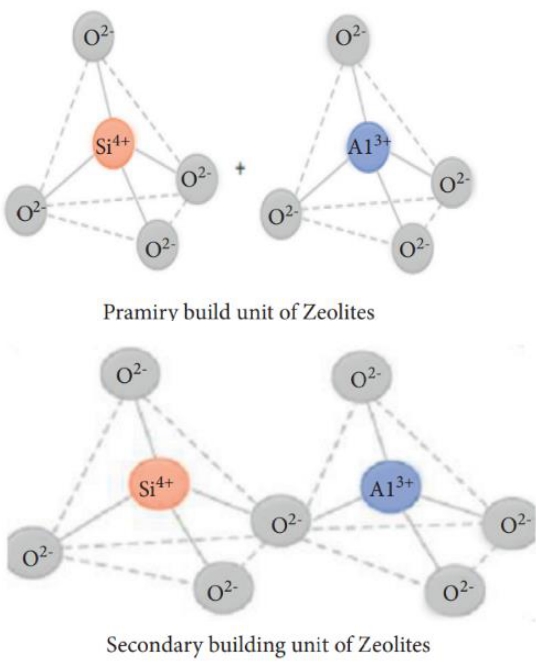
Figure 9. Primary and secondary building units of zeolites [48].